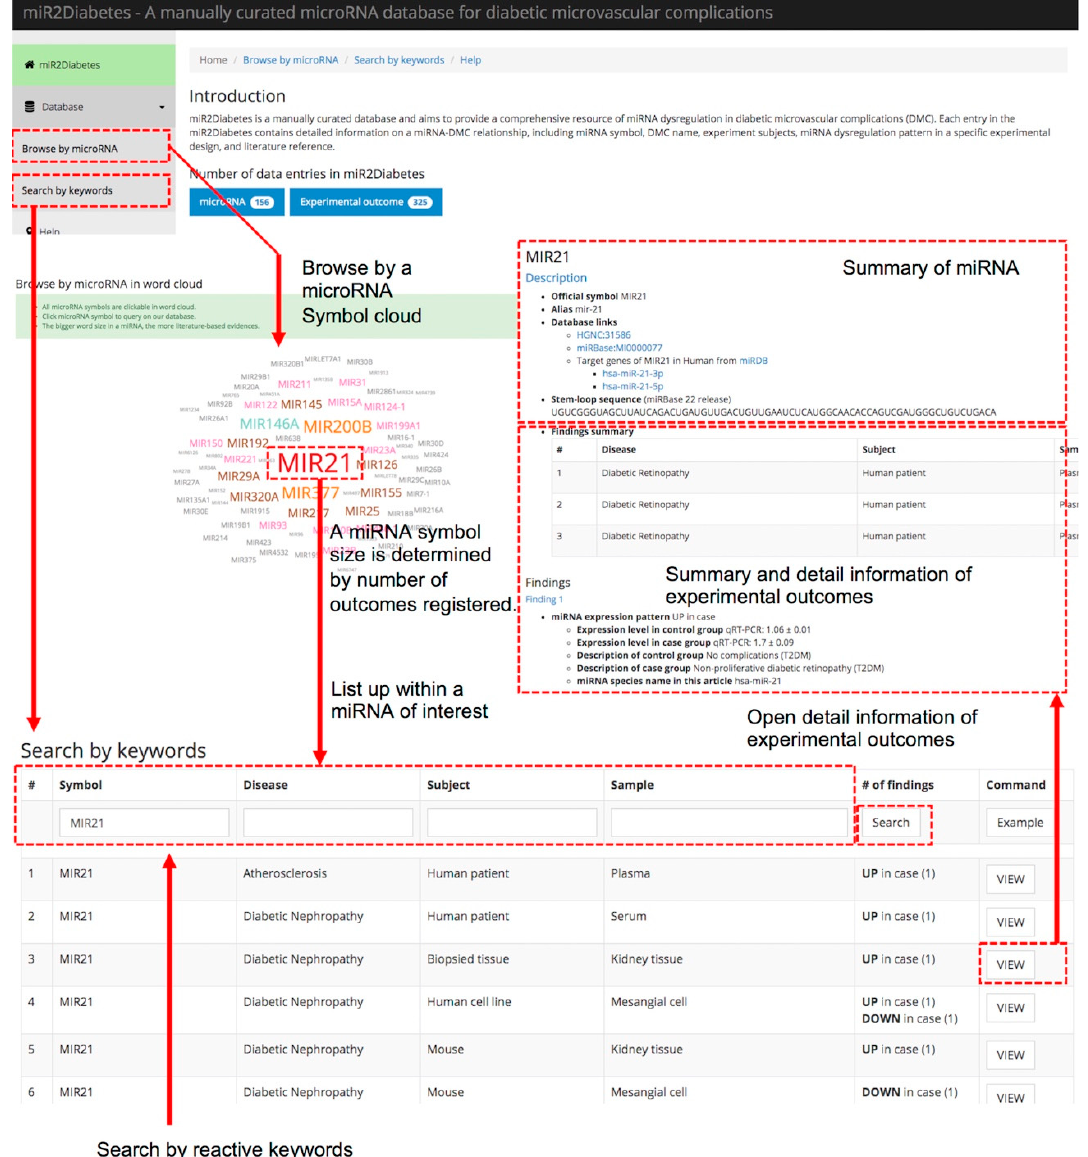
Figure 3. Schematic workflow of the miR2Diabetes database. As shown, the user may browse by microRNA names or by keywords. Selection of specific microRNAs (with word sizes based on publication occurrences) provides a summary of specific study outcomes and other detailed information. Filters provided include miRNA, disease, subject, type of tissue sample, and up- vs. down-regulation.